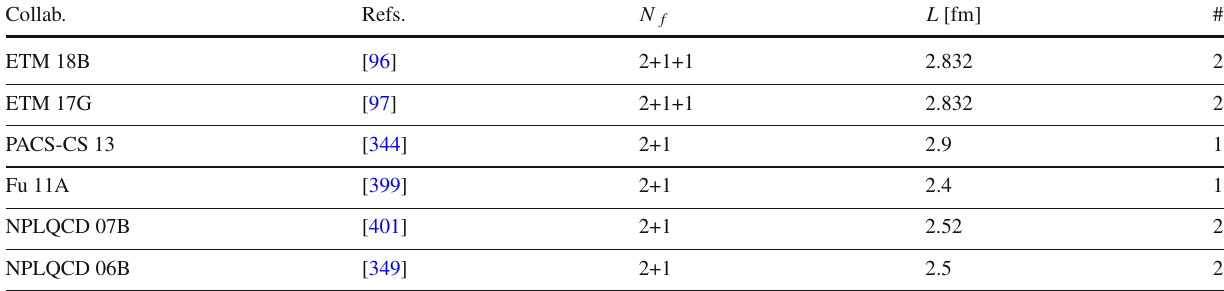
Table 120 Finite-volume effects in determinations of the low-energy constants related to π K scattering Collab.